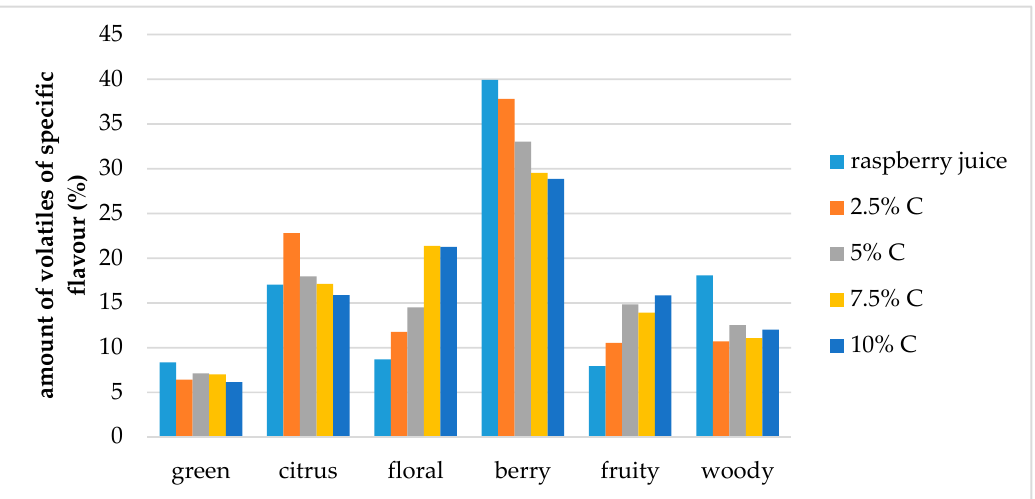
Figure 5. Amount of volatiles of specific flavor profile of raspberry juice and cellulose/raspberry complexes prepared by 15 min complexation (C—cellulose).